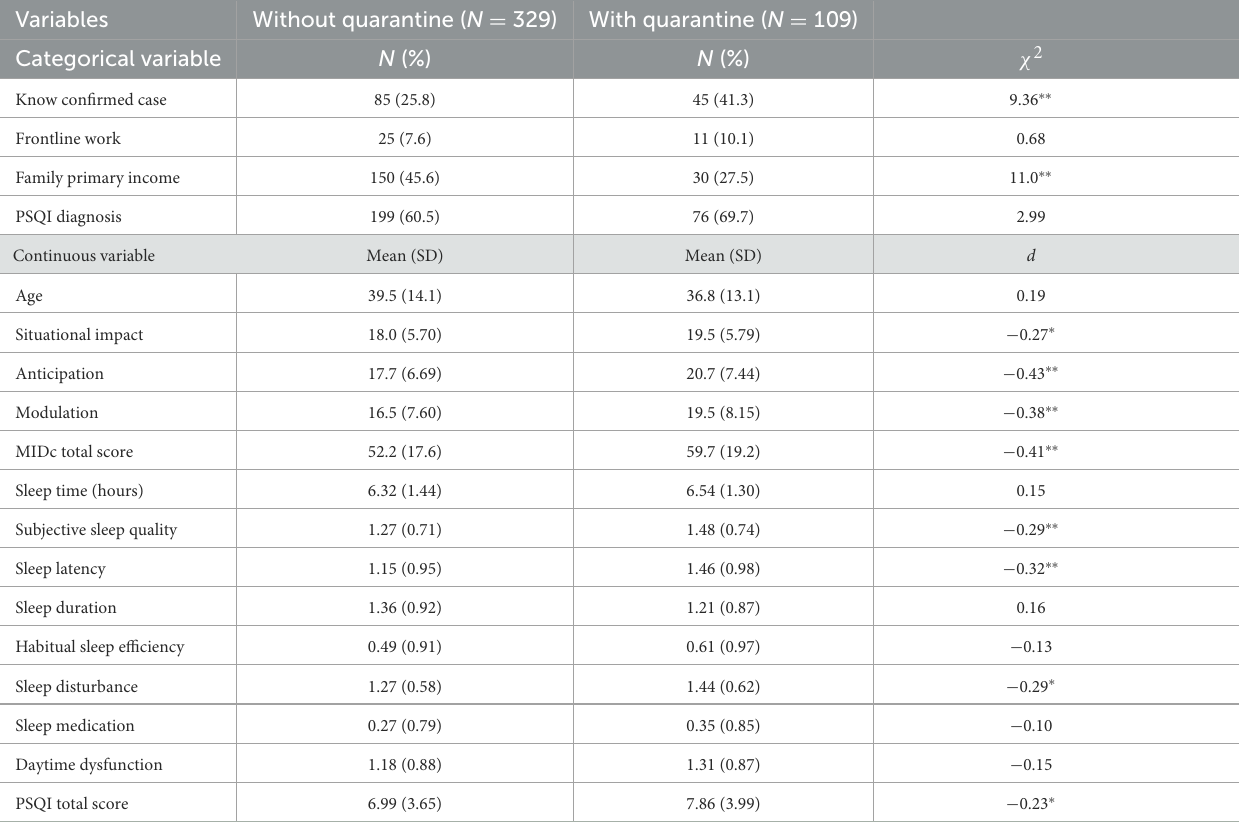
TABLE 2 Demographics and psychological profiles of the sample across quarantine experience.